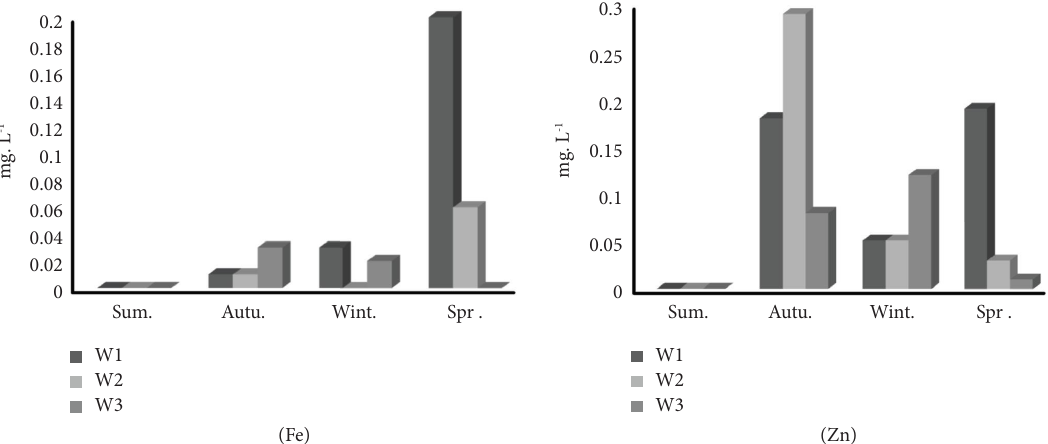
Figure 3: Heavy metals (Fe and Zn) of three groundwater (tube well) samples were collected near the dumping site during four seasons during